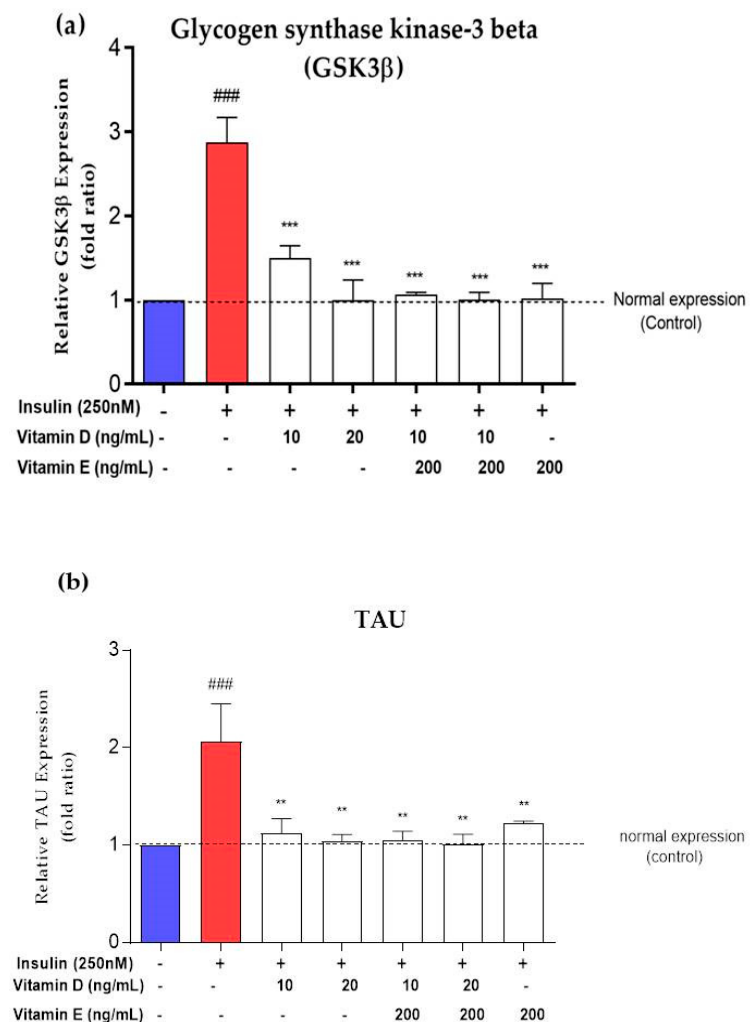
Figure 9. ( a ) GSK3 β and ( b ) TAU expressions level in insulin-resistant cells upon treatment with various concentrations of vitamins D and E. Red bar represents expression level upon induction with 250 nM insulin for 16 h. White bar represents expression level treated with vitamins D and E for 24 h after induced with 250 nM insulin. Relative GSK3 β and TAU expressions were normalized to GAPDH . Data were expressed as mean ± SEM of three independent experiments. Significant values were expressed as ** p < 0.01, *** p < 0.001 compared to the negative control group and ### p < 0.001 compared to the control group.